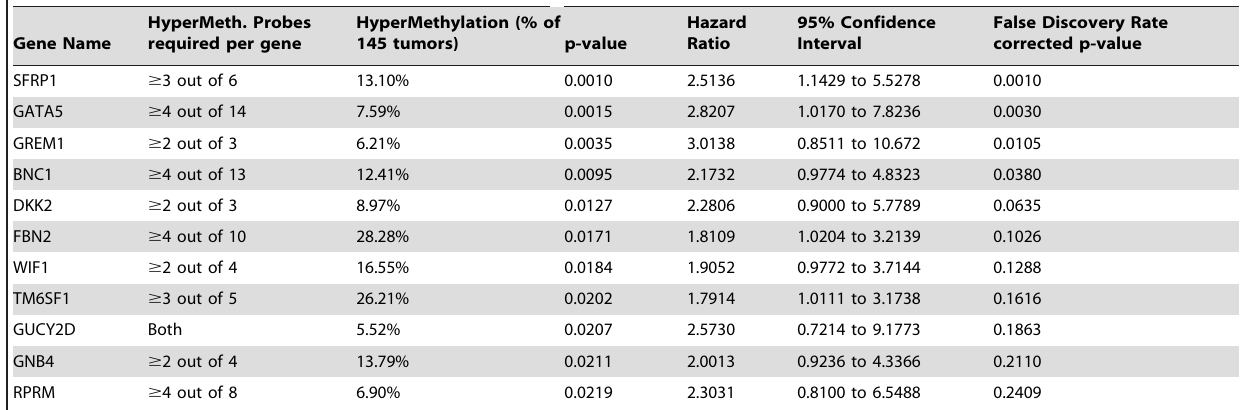
Table 4. Kaplan Meier Survival Analysis for the HumanMethylation450 BeadChip